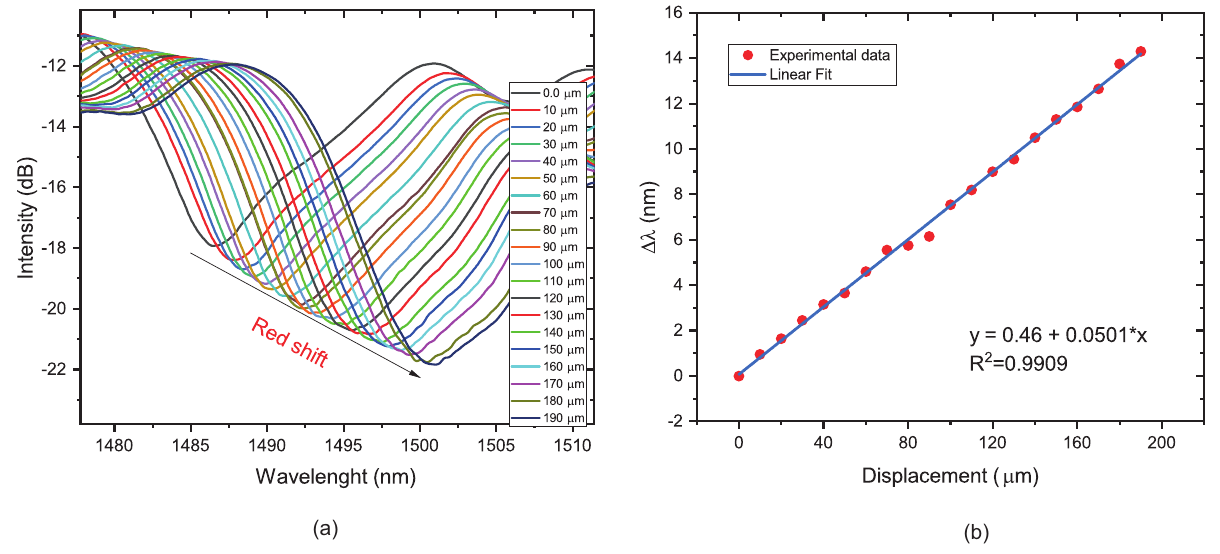
Figure 7. ( a ) Transmission spectra response for 5 mm of radius of curvature. ( b ) Dip wavelength changes as a function of the micro-displacement applied.